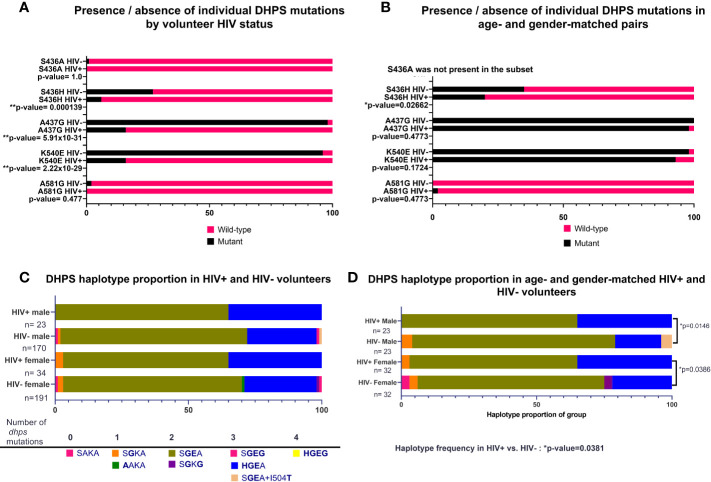
Presence of individual nonsynonymous mutations and proportions of DHPS haplotypes by HIV-1 status, or by age- and gender-matched pairs. (A) Individual mutations by HIV-1 status; n=361 mutations identified in HIV-negative volunteers, n=57 nonsynonymous mutations identified in HIV-positive volunteers. (B) Individual mutations in age- and gender-matched, HIV-positive and HIV-negative volunteers (n=46 males, n=64 females). S436H was significantly more prevalent in HIV-negative volunteers (p-value=0.02662). (C) Proportion of haplotypes in volunteers grouped by gender and HIV-1 status. (D) Haplotypes of age- and gender-matched pairs grouped by HIV-1 status. Significant differences were detected for HIV-positive males versus HIV-negative males (p=0.0146) and for HIV-positive females versus HIV-negative females (p=0.0386) by Chi-square analysis. Haplotype proportions were also significantly different between HIV-positive males and females (n=55) versus HIV-negative males and females (n=55, p-value=0.0381).